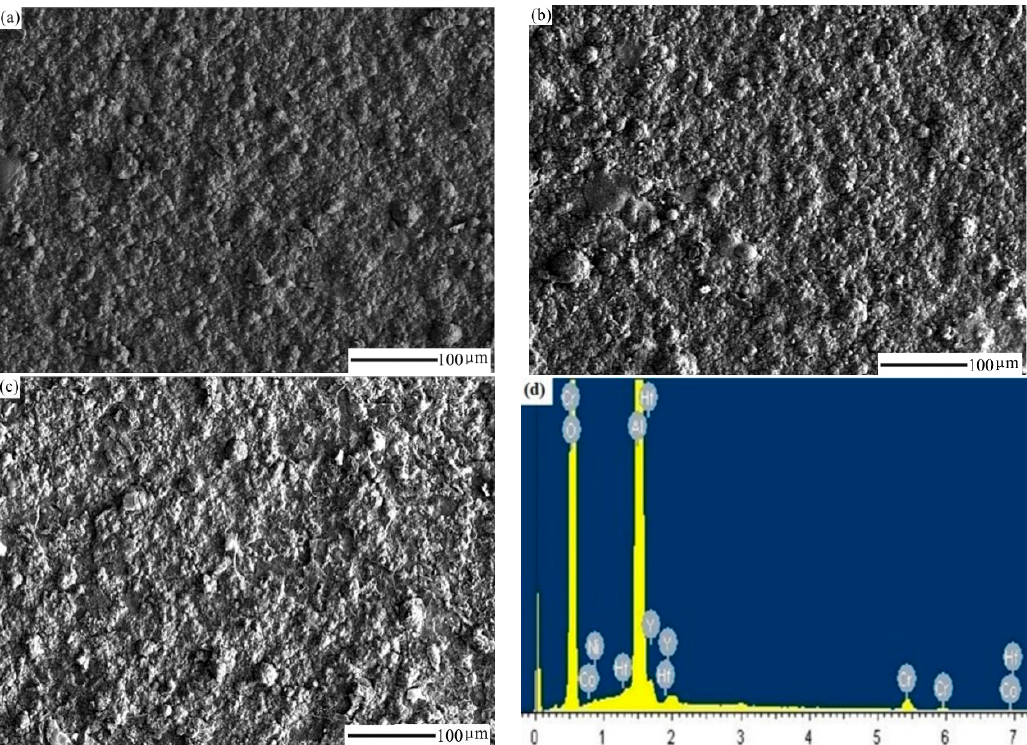
Figure 5. Backscatter-Electron (BSE) images of the surface morphologies of the carburized Ni-based single-crystal superalloy with an HY5 coatings after thermal cyclic oxidation at 1100 °C for different oxidation times: ( a ) 300 h; ( b ) 600 h; ( c ) 1000 h. ( d ) EDS spectra of ( a ).